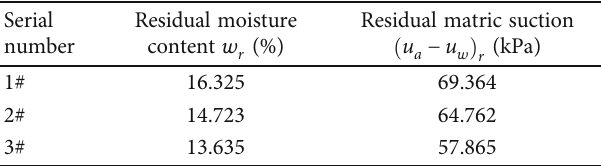
Figure 8: SWCC of three kinds of foundation soil. Table 5: Modi fi ed van Genuchten model fi tting parameters Table 4: Characteristic parameter of SWCC.